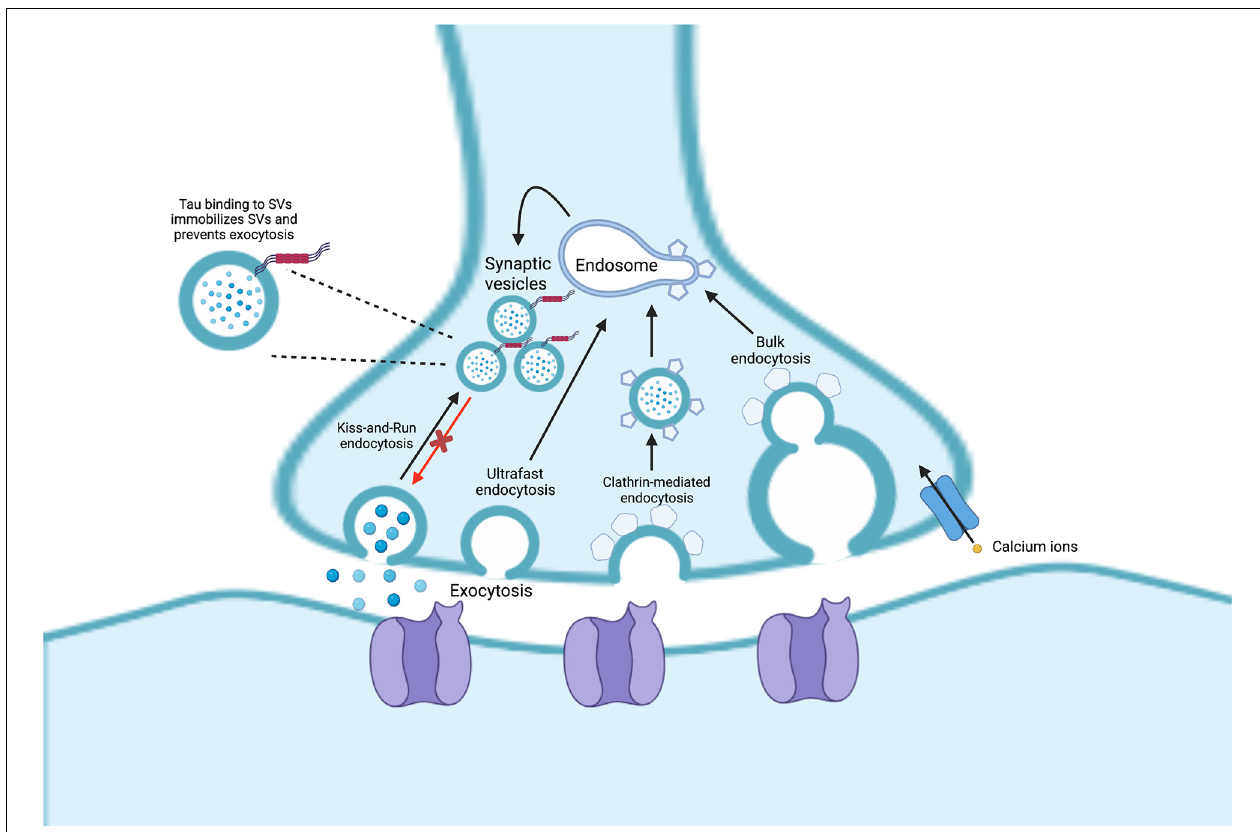
FIGURE 2 | Endocytosis of synaptic vesicles (SVs) can occur through four pathways: (1) “kiss-and-run” endocytosis; (2) ultrafast endocytosis; (3) clathrin-mediated endocytosis; and (4) bulk endocytosis. In Alzheimer’s disease (AD), pathogenic tau can bind to the SVs which can lead them to be less mobile, inducing SV clustering and reducing